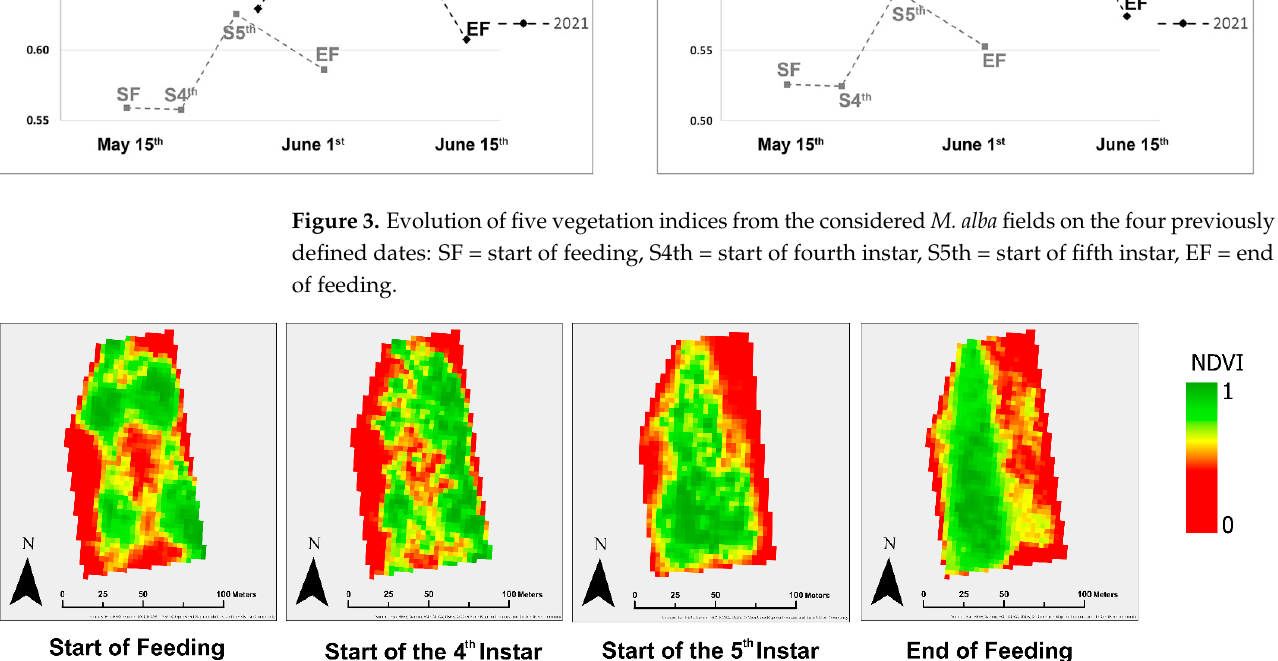
Table 5. Decrease in NDVI during 2020 and 2021 rearing seasons. Values of the decrease during the third and fourth instars and during the fifth instar are illustrated.